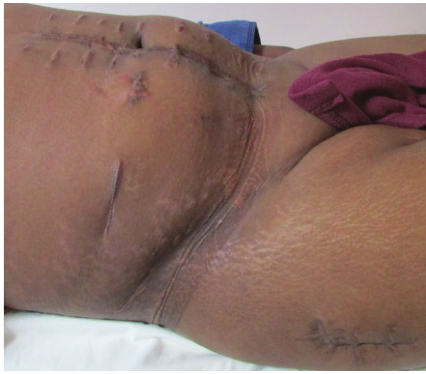
Figure 6: Healed, healthy scars of postoperative wounds at 6-month follow-up.